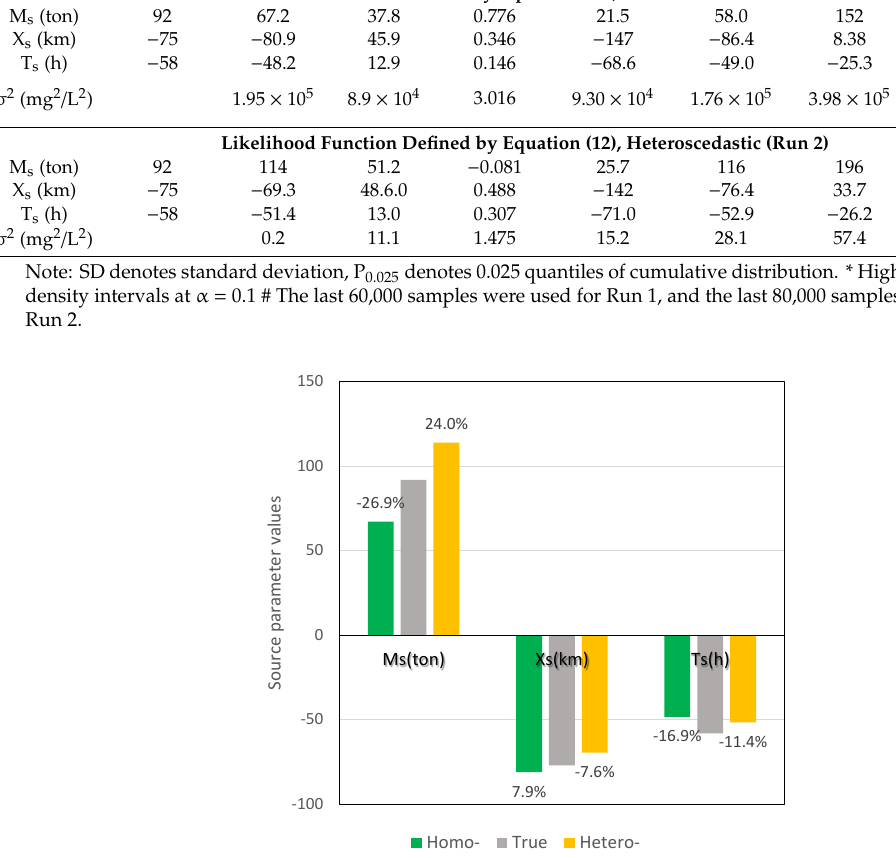
Table 3. Summary statistics of the inverse results at the Songhua River. Real Values